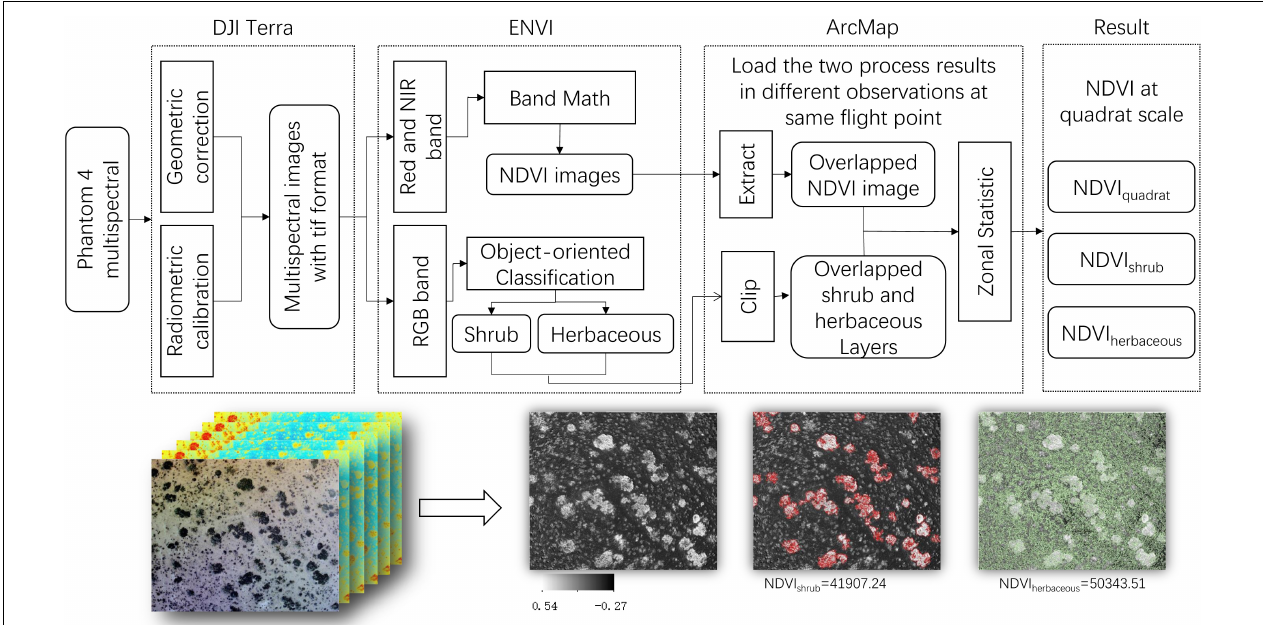
FIGURE 3 | The schematic diagram of the reprocessing of aerial photos. NDVI quadrat denotes the NDVI value of aerial photos, NDVI shrub and NDVI herbaceous denote the NDVI values of shrub and herbaceous,